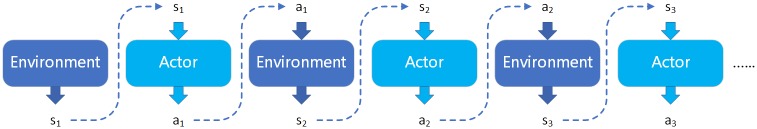
The process of a trajectory.